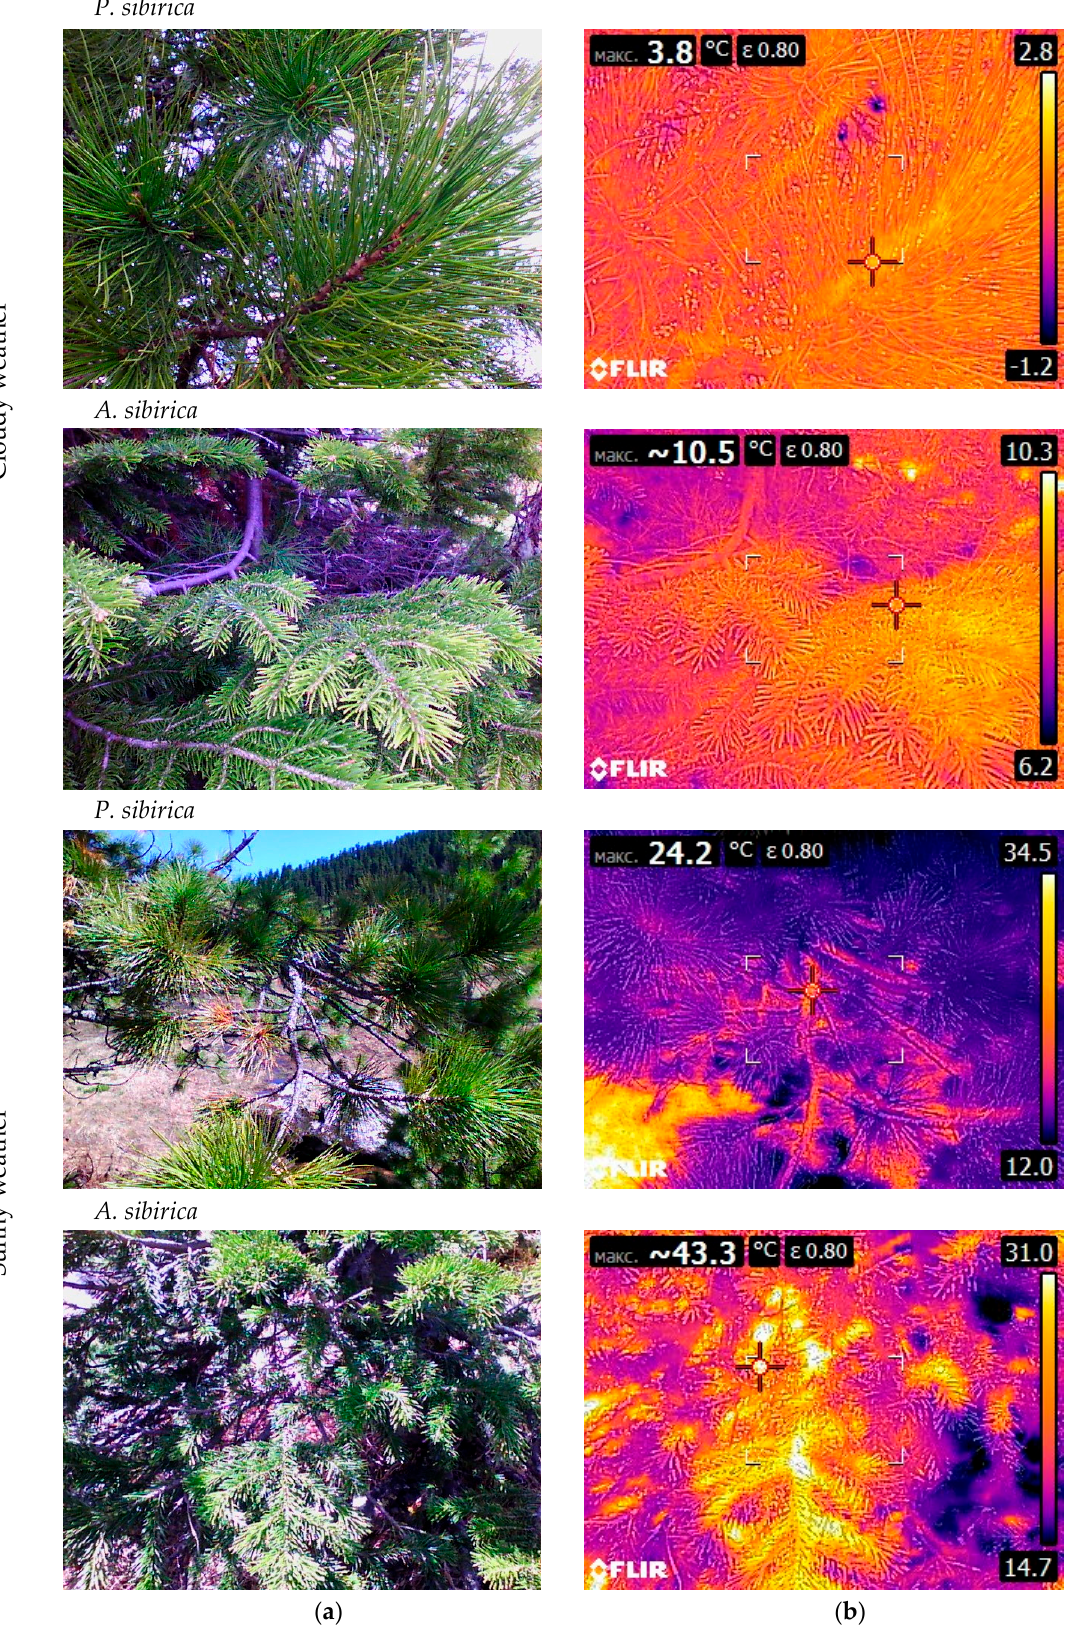
Figure 7. Photographs ( a ) and thermal images ( b ) of the young needles in P. sibirica and A. sibirica under cloudy (upper four images) and sunny (lower four images) weather.